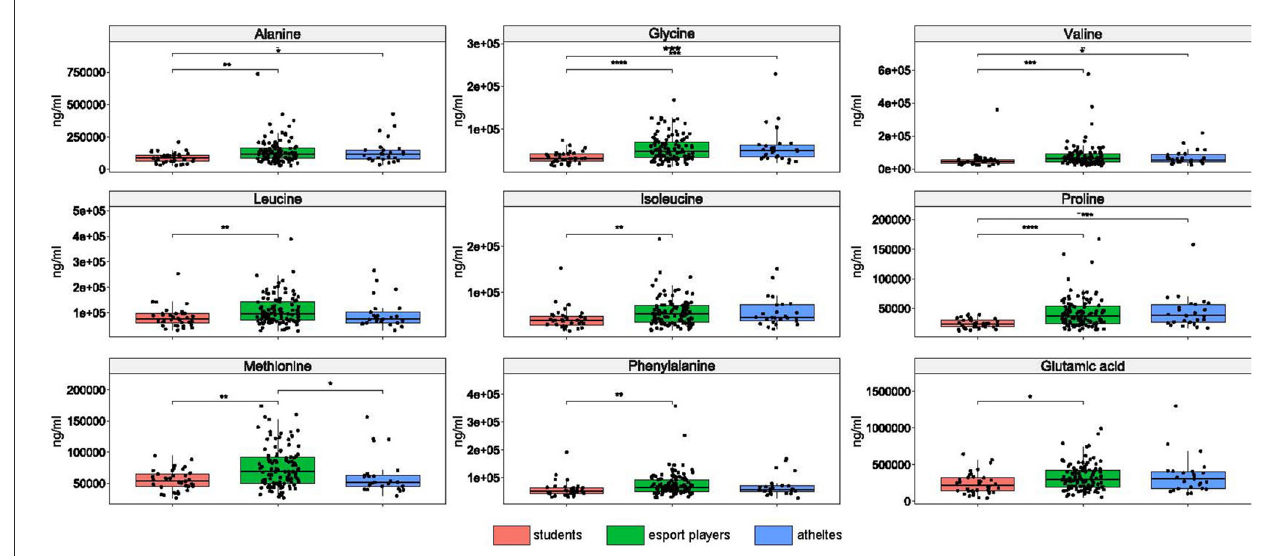
FIGURE6 Differences in amino acid concentrations between the groups. *: p ≤ 0.05, **: p ≤ 0.01, ***: p ≤ 0.001, ****: p ≤ 0.0001.